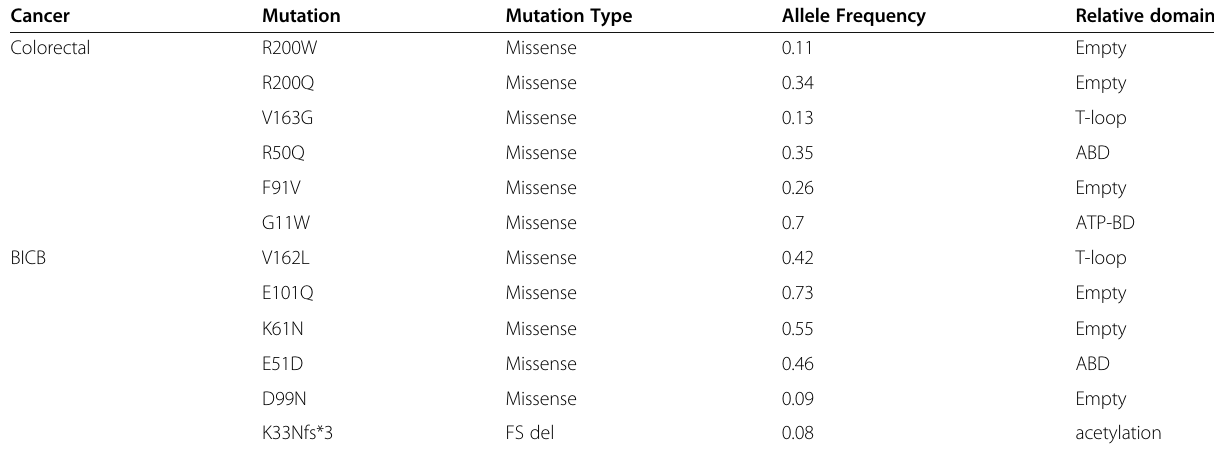
Table 1 Summary of mutation sites in corresponding domain of CDK5 and their allele frequencies in clinical cancer samples (Continued) Cancer Mutation Mutation Type Allele Frequency Relative domain Colorectal R200W Missense 0.11